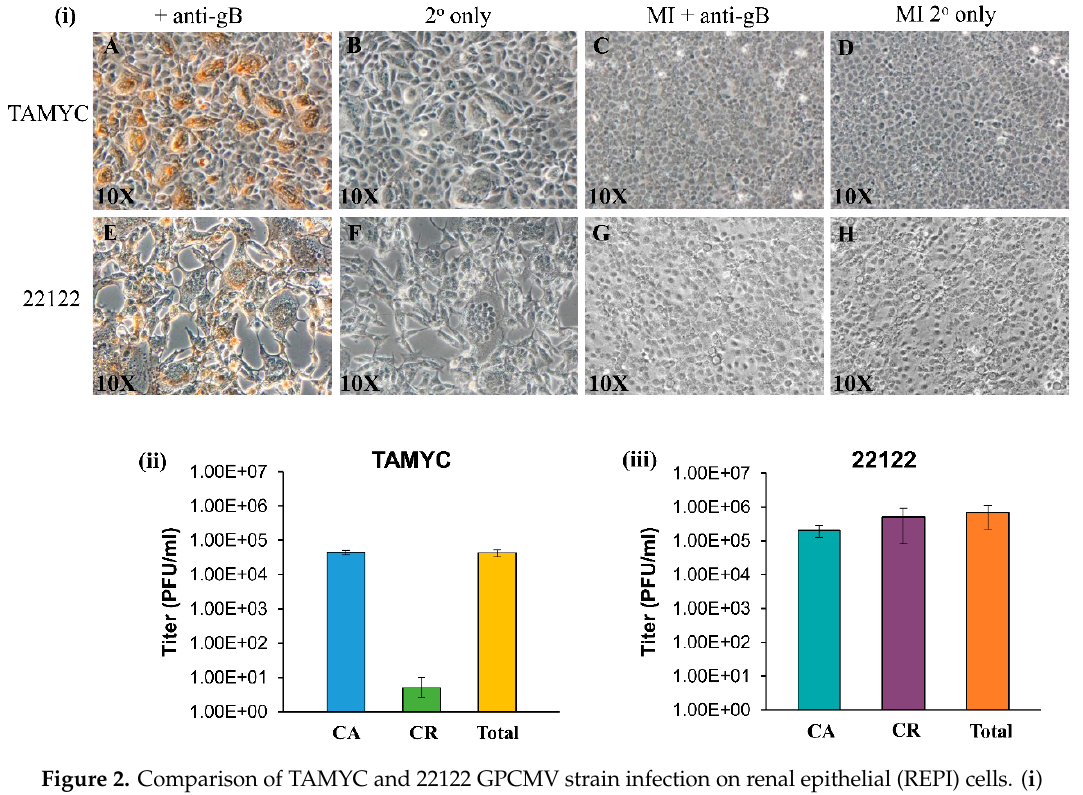
Figure 2. Comparison of TAMYC and 22122 GPCMV strain infection on renal epithelial (REPI) cells. ( i ) Viral gB protein staining of renal epithelial (REPI) cells infected with TAMYC strain ( A – D ) or 22122 strain ( E – H ) were carried out in six ‐ well plates. Monolayers infected with TAMYC or 22122 strain GPCMV (moi 1 pfu/cell) ( A , B , E , F ) and mock infected (MI) monolayers ( C , D , G , H ) were immunostained with monoclonal anti ‐ gB (GPCMV) primary antibody (Dr. Britt, UAB) + anti ‐ mouse IgG ‐ HRP secondary (Vectastain) ( A , C , E , G ) or secondary antibody only ( B , D , F , H ). Individual bright field images are representative of multiple fields (minimum 10 per panel). Magnification 10×. ( ii , iii ) Evaluation of cell ‐ associated (CA), cell ‐ released (CR) fractions and total virus titer at 3 days post infection (dpi) on REPI cells from 6 well plates for TAMYC ( ii ) and 22122 ( iii ).